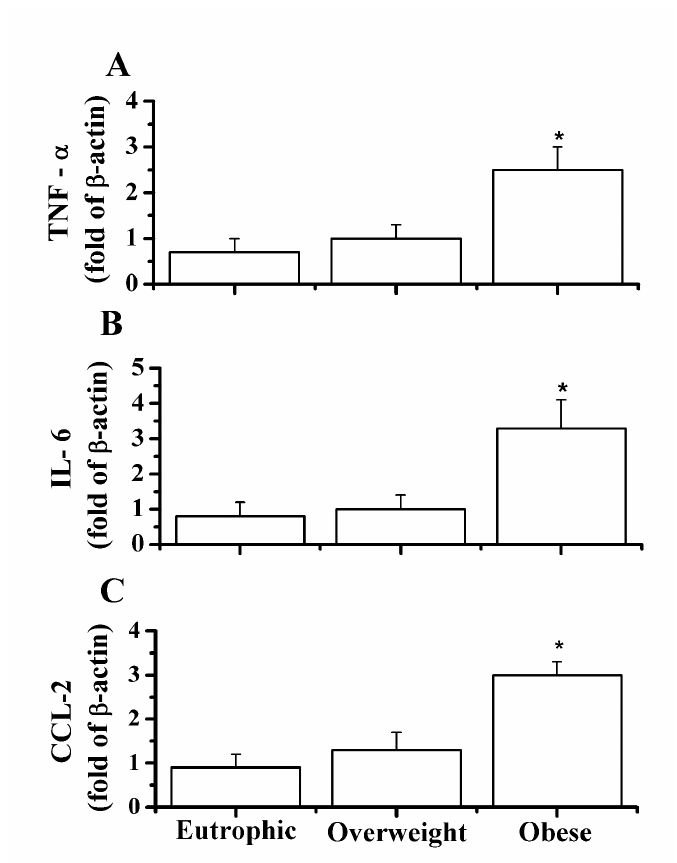
Figure 3. Genic expression of inflammatory biomarkers. (A) Tumor necrosis factor alpha (TNF-α). (B) Interleukin 6 (IL-6). (C) Chemokine C-C motif ligand 2 (CCL-2). Data are expressed as mean ± standard deviation. Eutrophic (n = 36). Overweight (n = 34). Obese (n = 24). *, significantly different from eutrophic individuals ( p <.05).